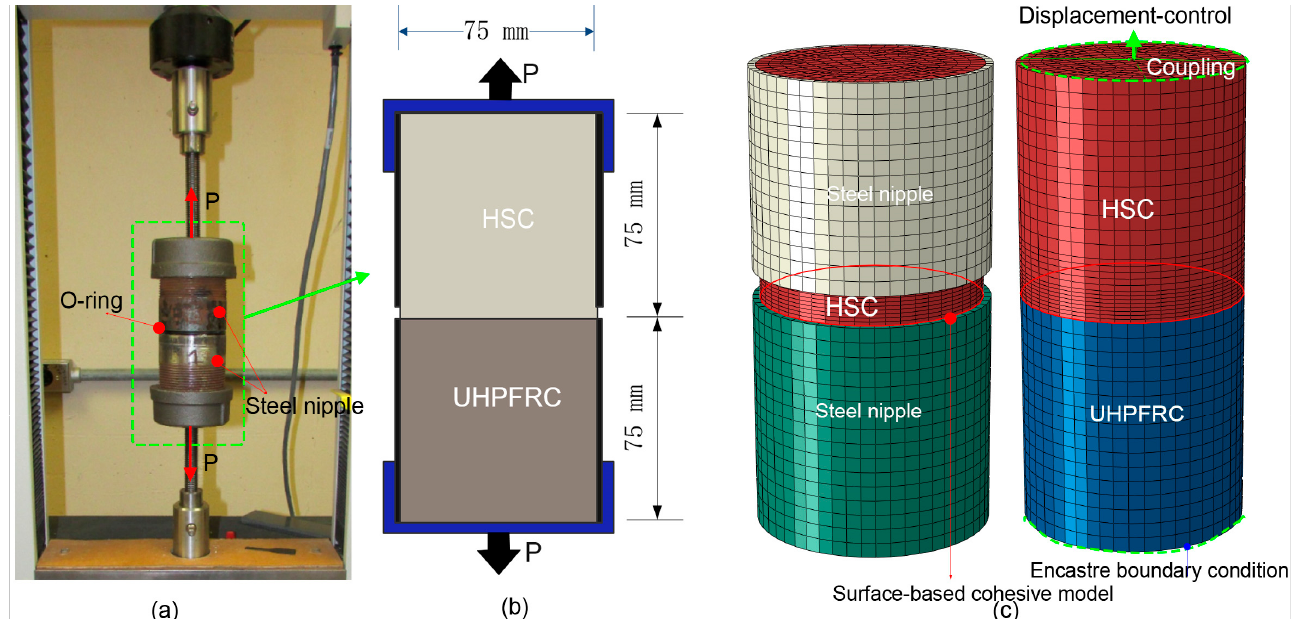
Figure 8. Pure tensile test: ( a ) experimental setup [21]; ( b ) dimensions of the specimens; and ( c ) FE model. Table 6. Properties of HSC along with CDP model parameters in compression and tension in the tensile test.